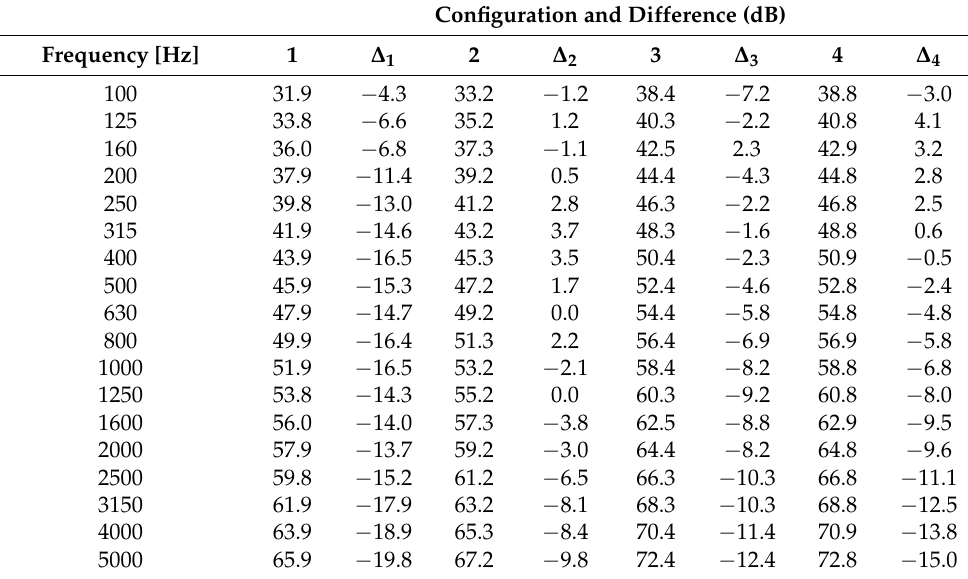
Table 5. Calculated sound insulation values, using Sharp’s theory. ∆ n represents the difference between the measured and calculated